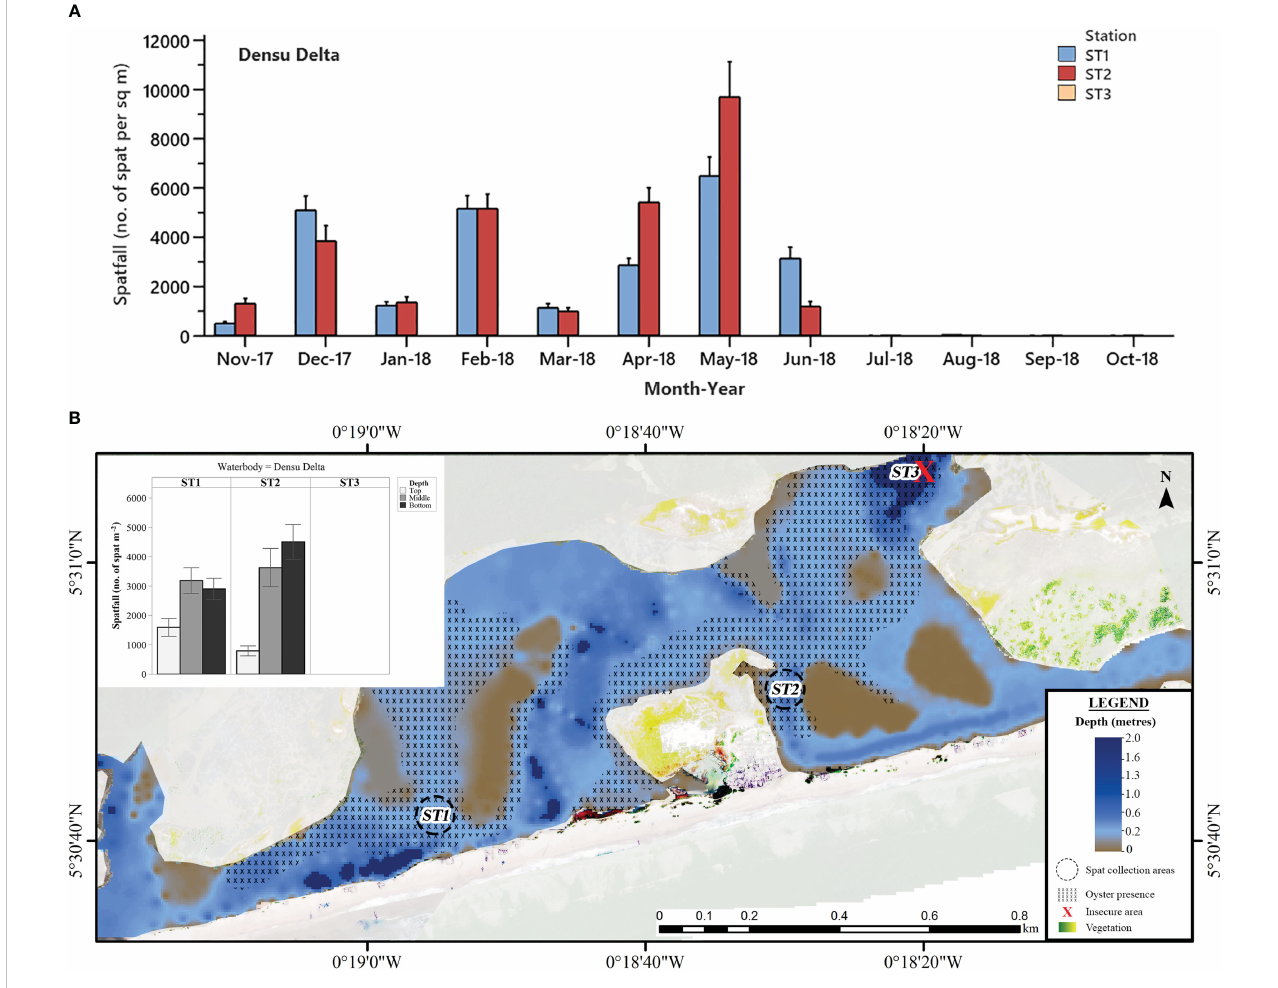
FIGURE 3 (A) Mean monthly C . tulipa spatfall (spat m -2 ) at stations (ST) in the Densu Delta pooled from collectors at all depths for each water body. Interval bars are standard errors (S.E.) of the mean. (B) Geomorphological representation of the estuarine section of Densu Delta at low tide showing depth pro fi le, oyster presence and charted C . tulipa spat availability in water column at the experimental spat collection stations. Map generated from orthomosaic image of UAV fl ights for this study in June